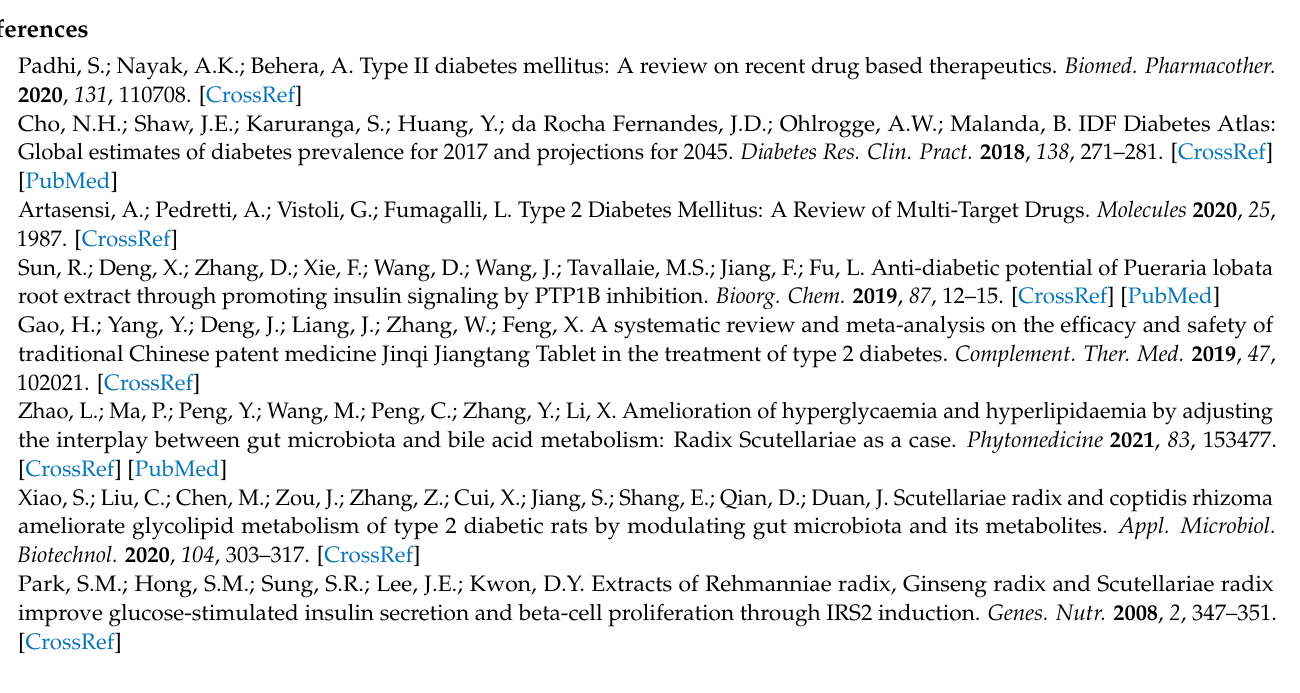
for Scutellariae Radix in diabetes. Table S2: The biological process of the therapeutic targets of Scutellariae Radix. Table S3: Cellular component of the therapeutic targets of Scutellariae Radix. Table S4: Molecular function of the therapeutic targets of Scutellariae Radix. Table S5: KEGG analysis results of the therapeutic targets of Scutellariae